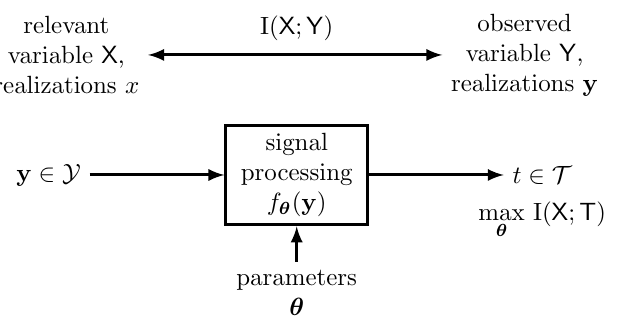
Figure 2. Optimizing parameters in a parametrized information bottleneck like setup. The parameters θ shall be tuned to maximize I ( X ; T ) for a given parametrized function f θ ( y )